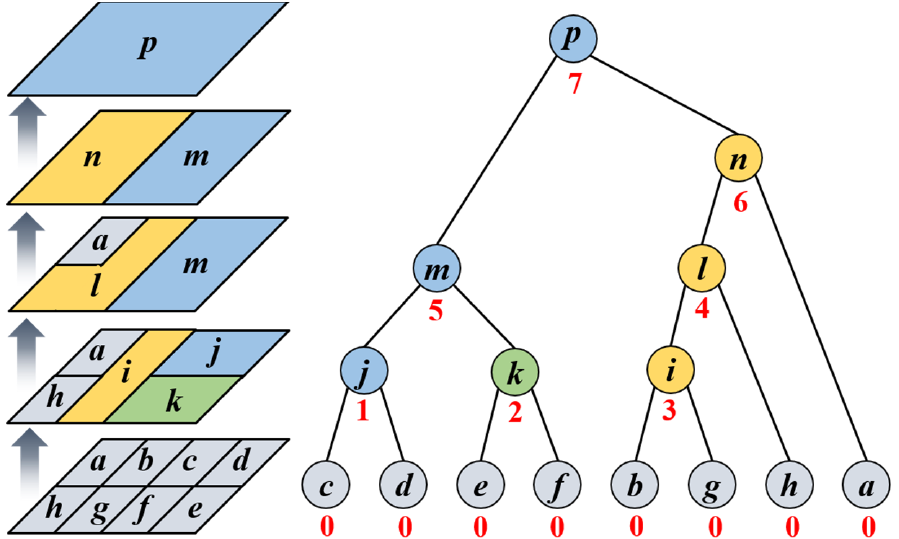
Figure 1. The BPT construction diagrams. ( left ) The 3-D BPT construction process. ( right ) The hierarchical structure of BPT construction. The letters represent the indexes of the objects, the numbers represent the iteration numbers of each node, different colors represent different node objects.